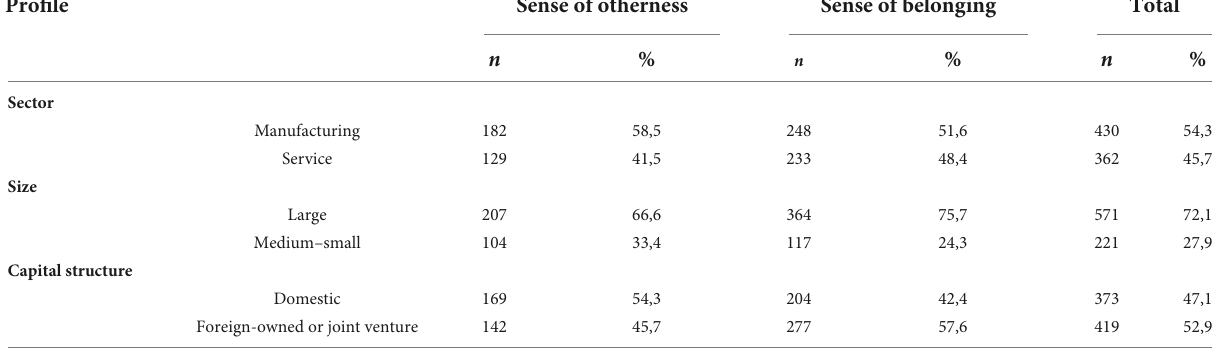
TABLE 2 Profile of the organizations where respondents